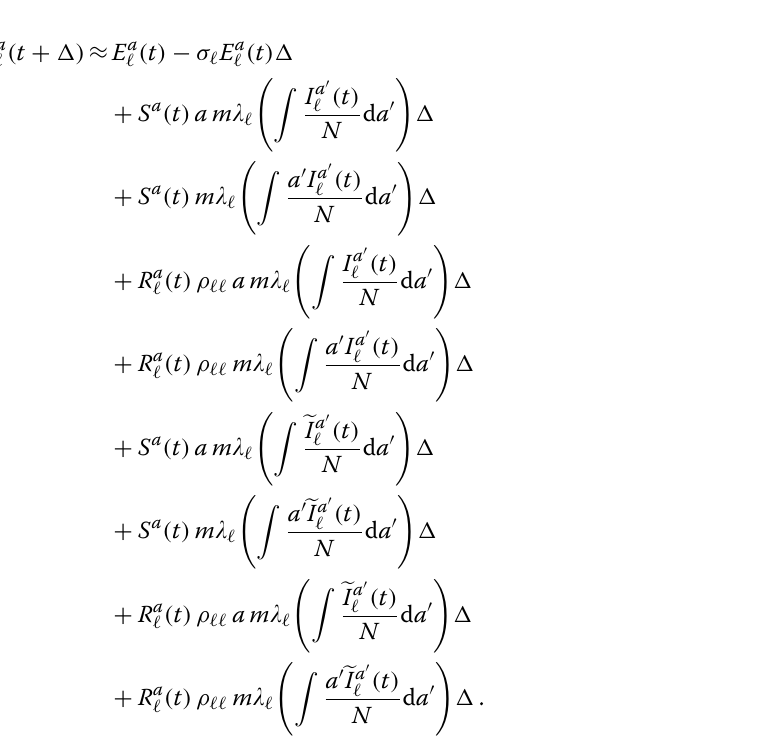
( t ) . In addition, using equation (1), the I a ℓ